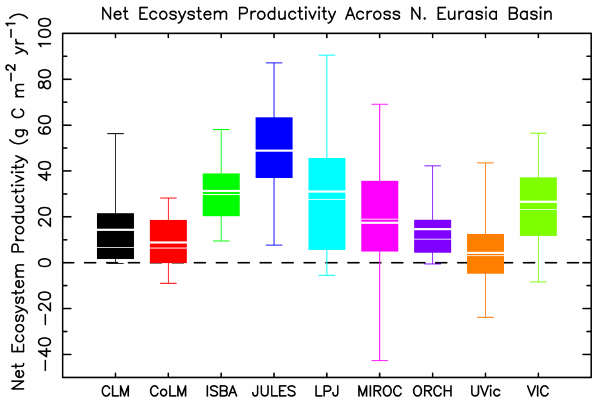
Figure 9. Distributions for mean annual NEP from the models over the averaging period listed in Fig. 5. Boxplot quartiles are as de- scribed in caption for Fig.